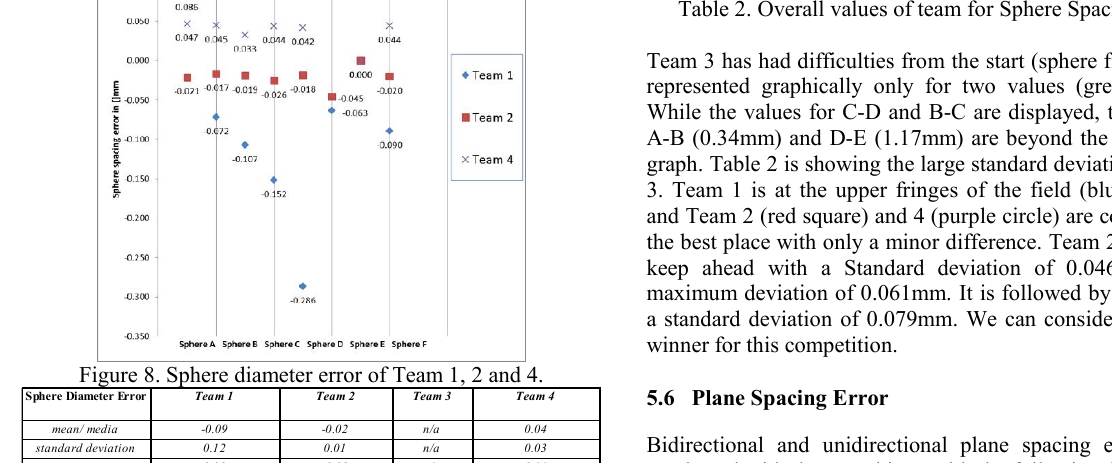
Figure 8. Sphere diameter error of Team 1, 2 and 4.